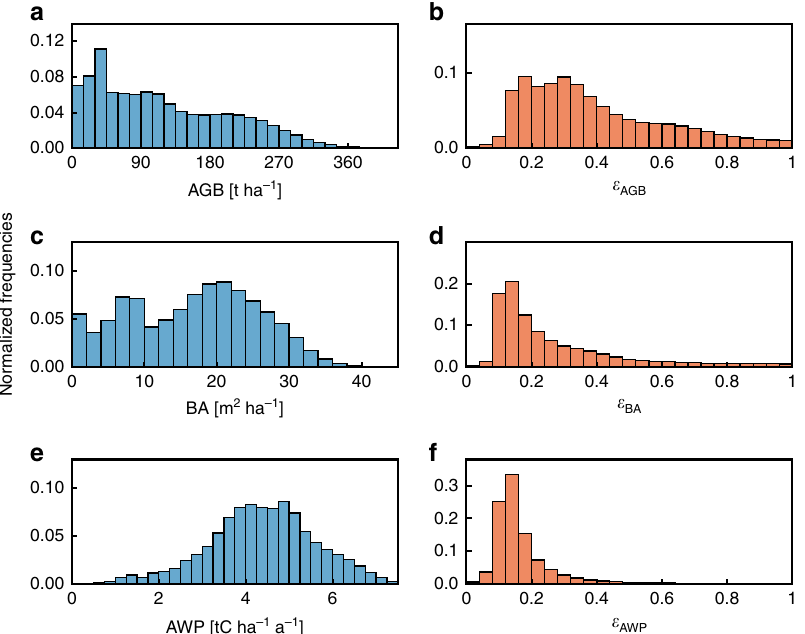
Fig. 3 Frequency distributions of forest attributes and uncertainties. (left) Relative frequency distributions of a aboveground biomass (AGB), c basal area BA, and e aboveground wood productivity (AWP) for the Amazon based on 771,521 full lidar pro fi les. (right) Frequency distributions of the uncertainties for b biomass ε AGB , d basal area ε BA , and f aboveground wood productivity ε AWP (see Supplementary Fig. 1 for ε SV , ε GPP ). Source data are provided as a Source Data fi